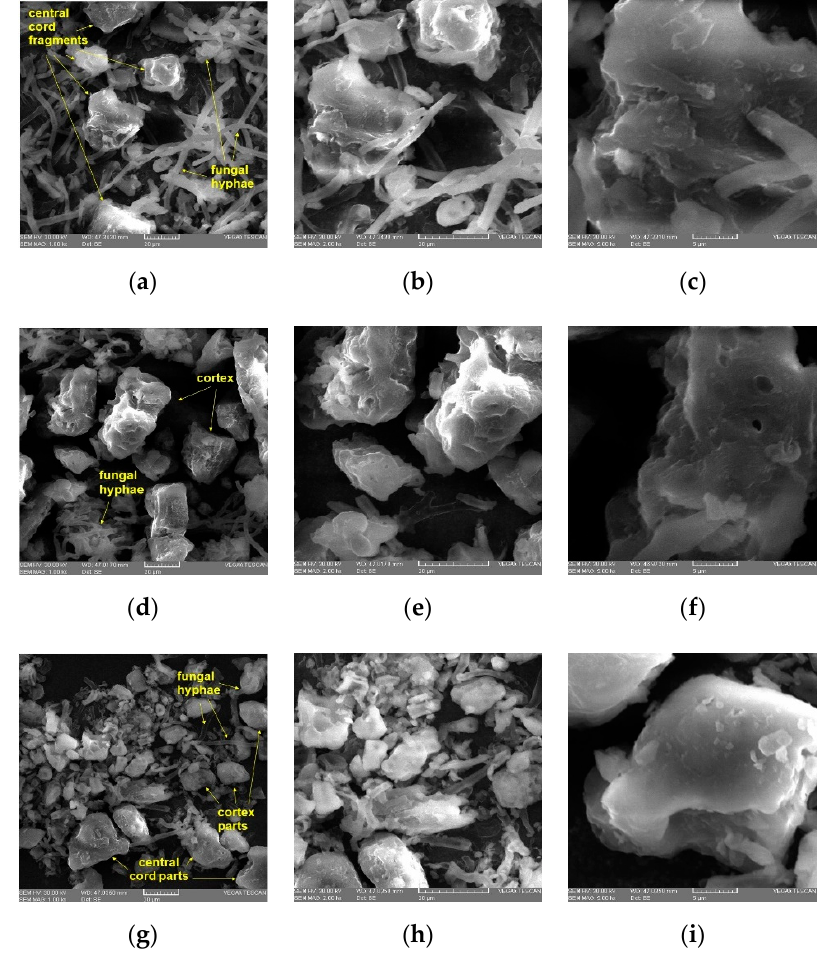
Figure 5. SEM micrographs of cc UB, mc UB, and d UB as a fine powder (particle size ≤ 180 μ m): cc UB ( a – c ); mc UB ( d – f ); d UB ( g – i ) with different magnifications: 1 k × and scale bar = 20 µ m ( a , d , g ), 2 k × and scale bar = 20 µ m ( b , e , h ), and 5 k × and scale bar = 5 µ m ( c , f , i ). Table 1. Color evaluation of U. barbata